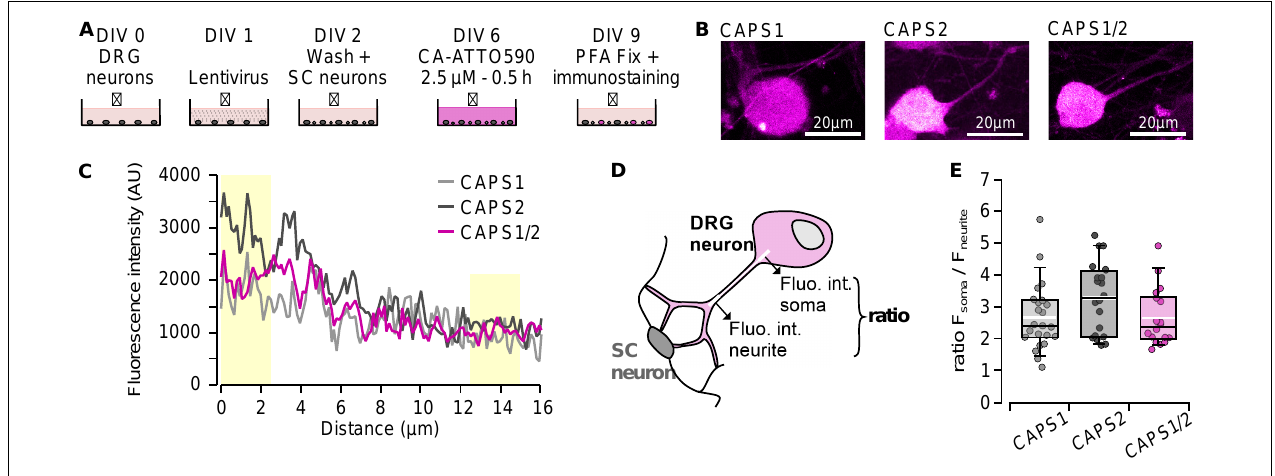
FIGURE 4 | CAPS2 accumulates in the cell soma, while CAPS1 and CAPS1/2 chimera move into the neurites. (A) Schematic staining protocol. DRG and SC neurons were isolated from CAPS dKO and WT mice, respectively. (B) Representative DRG neuron somata transfected with either CAPS-Halo construct and stained with CA-ATTO590. (C) Line scan analysis performed on the neurons shown in (B) . The lines were drawn from 3 µ m in the soma to 13 µ m in the neurites and had a width of three pixels. Yellow boxes correspond to the portion of the line used for the analysis depicted in (D) . (D) Schematic representation of the method used to determine the distribution of CAPS-Halo from the soma in the neurite. A fluorescence intensity profile of Halo ligand CA-ATTO590 (magenta) was measured along a 15 µ m long line shown in white. The relationship between somatic and neurite fluorescence was calculated as a ratio between the fluorescence intensities over the first and last 2.5 µ m on the line (thick ends). (E) Ratios of CA-ATTO590 soma vs. neurite fluorescence intensity in neurons expressing CAPS1-, CAPS2b-, or CAPS1/2 chimera-Halo. Box plots display median (black line) and mean (white line). n = 23, n = 20, and n = 18 for CAPS1, CAPS2b, and CAPS1/2, respectively, N experiment = 4. The differences between CAPS2b and CAPS1 or CAPS1/2 chimera are not